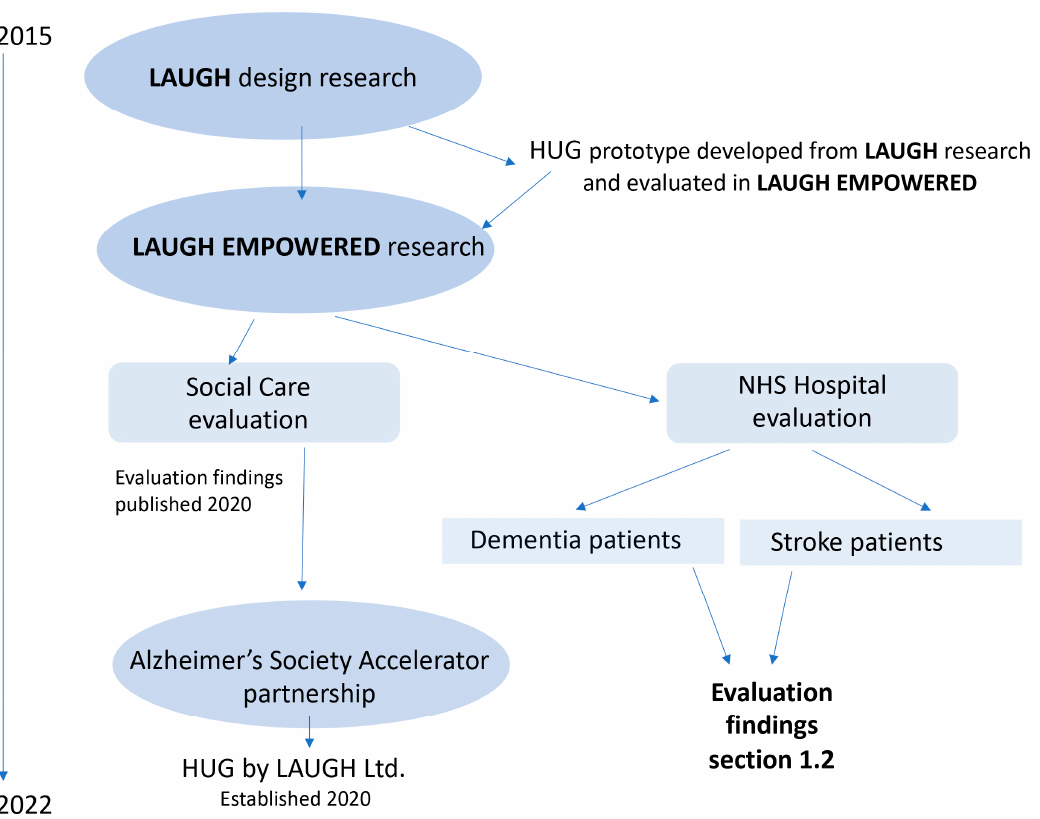
Figure 1. Timeline and structure of the research and product.